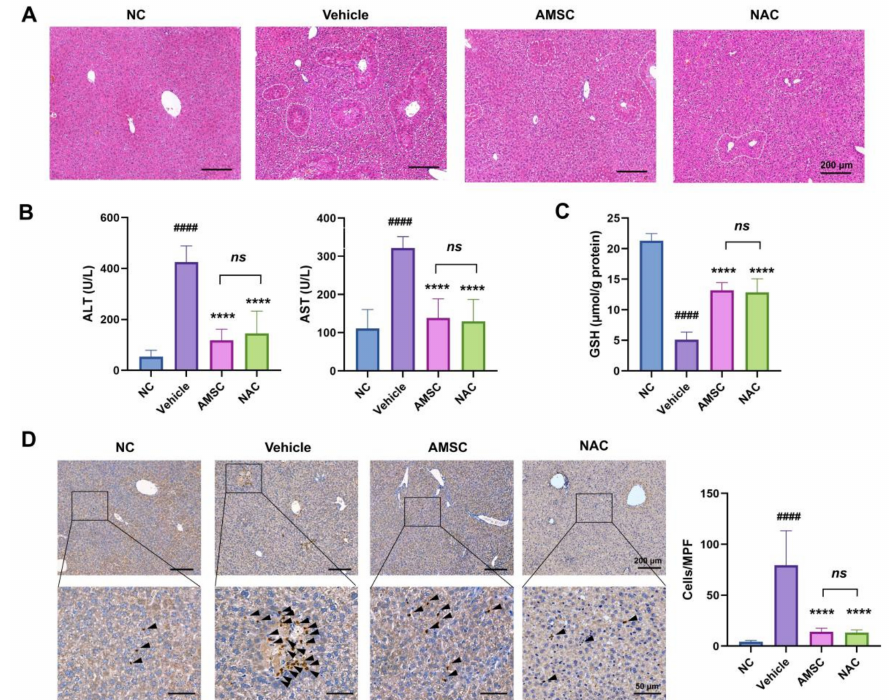
Figure 1. Effects of AMSC therapy on mice exposed to 500 mg/kg APAP. ( A ) Representative HE- staining and quantitation of the necrosis area in liver sections obtained from normal control (NC group), APAP-overdosed (vehicle group), AMSC-injected (AMSC group), and NAC-treated (NAC group) mice for 24 h. ( B ) Serum ALT and AST. ( C ) Hepatic GSH level. ( D ) Representative Ly6G IHC analysis. The positive cells were pointed out by arrowheads. Quantification of positive cells in each group per medium power field (MPF) using a 20 × objective. Data were expressed as mean ± SD; n = 5; #### p < 0.0001 vs. NC group; **** p < 0.0001 versus vehicle group; ns: no significance versus NAC